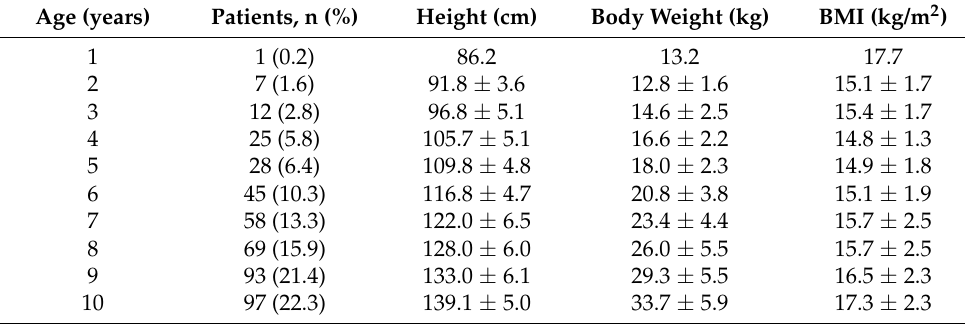
Anthropometric data are shown as the mean ± SD. BMI, body mass index.